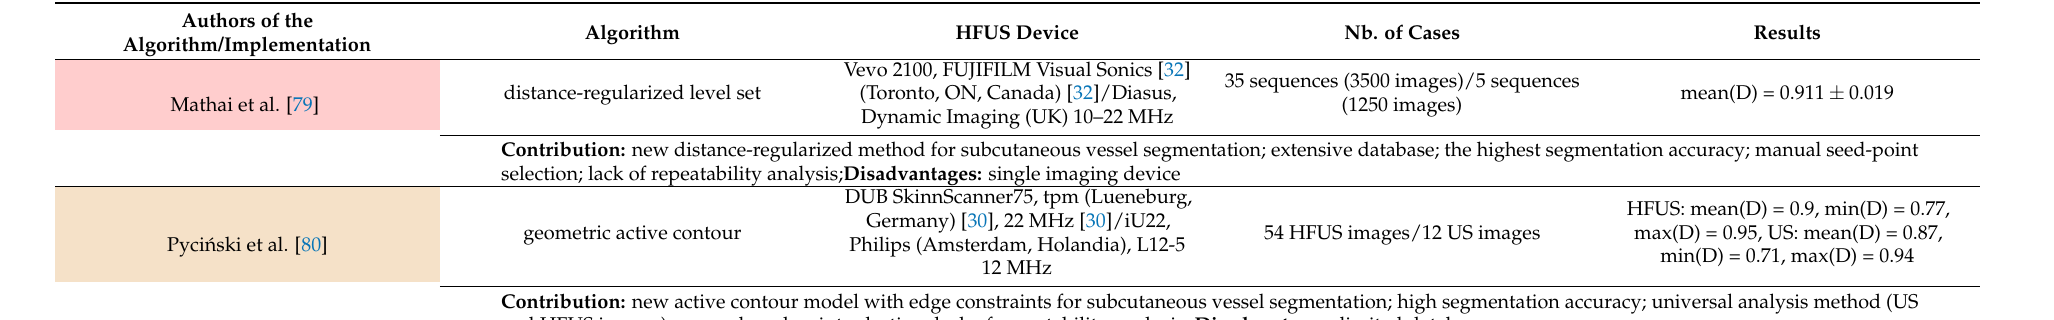
Table 7. Skin vessel segmentation summary.